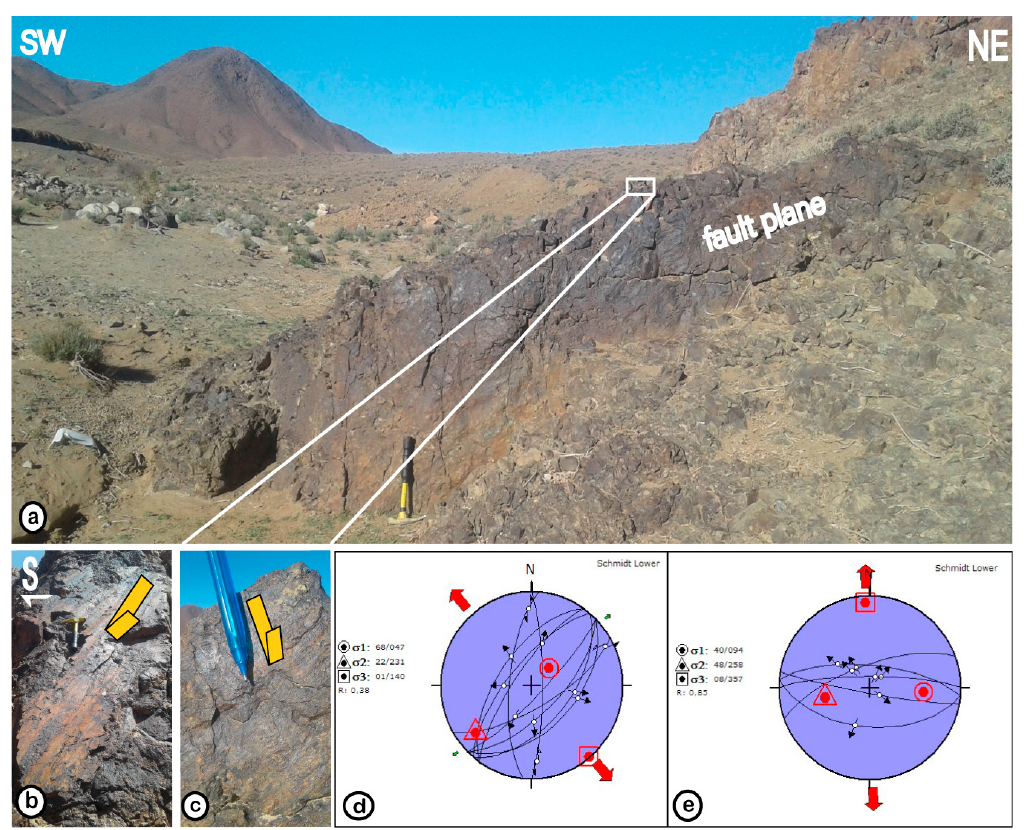
Figure 10. ( a – c ) Field photos shows a normal fault; ( d , e ) stereograms and stress axes orientation during the NW-SE extensional stage responsible for the Imiter fault collapse.